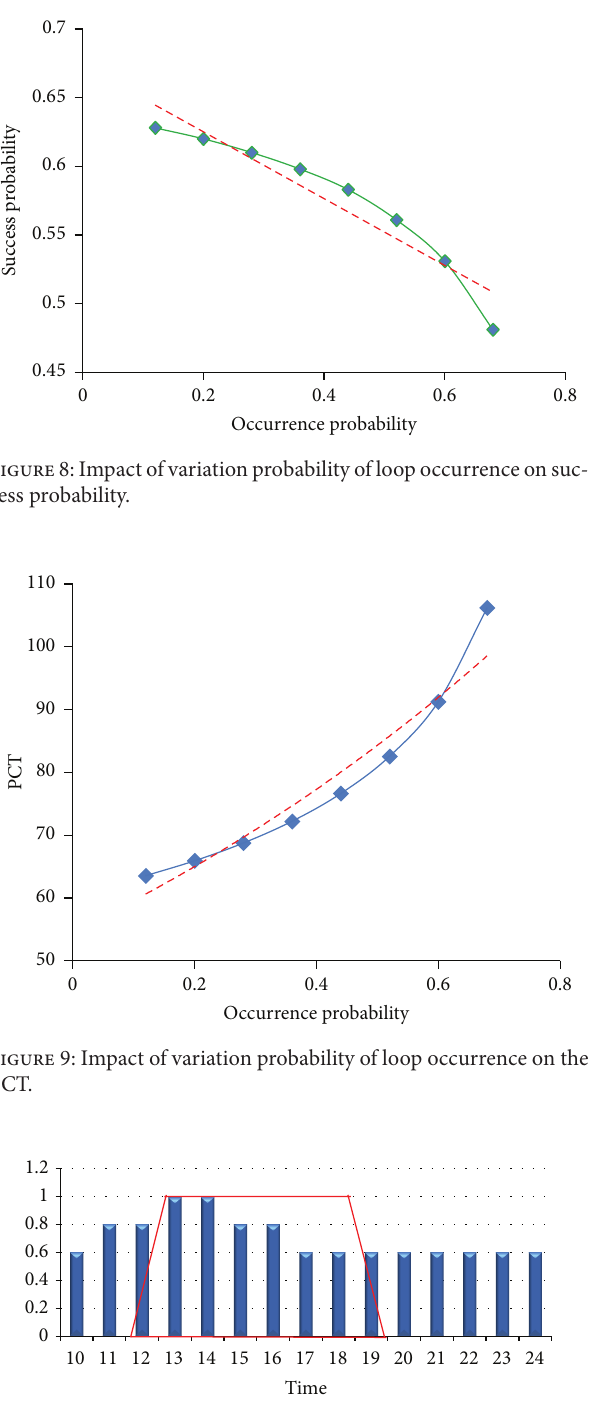
Figure 10: Fuzzy time of Itakura and the proposed algorithm.